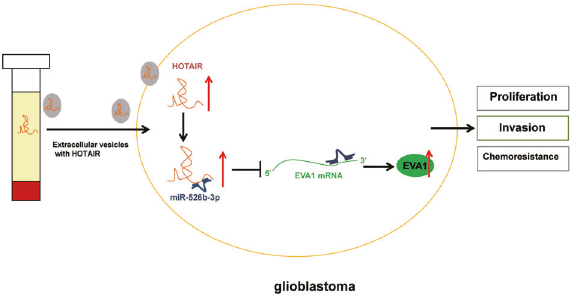
Fig. 7 Schematic diagram of the mechanism by which GBM- serum-EVs affect GBM cell proliferation, invasion, and chemore- sistance. GBM-serum-EVs deliver HOTAIR to GBM cells, where HOTAIR binds to miR-526b-3p and upregulates the expression of its target gene EVA1, thereby stimulating the proliferation, invasion, and chemoresistance of GBM